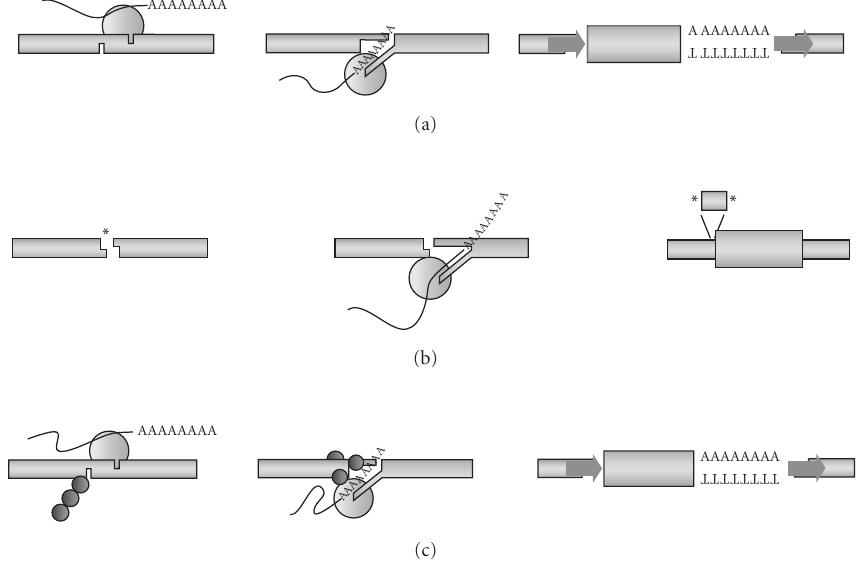
Figure 2: Potential ways in which DNA damage could influence L1 retrotransposition. (a) Endonuclease-dependent insertion under normal conditions. The L1 endonuclease ( (cid:3) ) makes staggered nicks at the target site, creating 3 (cid:2) overhangs. Filling in generates 7–20 base pair target ) flanking the insertion. (b) Endonuclease-independent insertion at the site of a double-strand break. The preexisting site duplications ( (cid:0) double-strand break shown here lacks staggered nicks or overhangs. L1 entry into this site would therefore also lack target site duplications. Genomic deletions may occur due to processing by cellular DNA repair processes ( ∗ ). (c) Endonuclease-dependent insertion potentiated by DNA damage. DNA damage may upregulate cellular cofactors of reverse transcription and integration ( endonuclease-dependent, but occurs at an increased e ffi